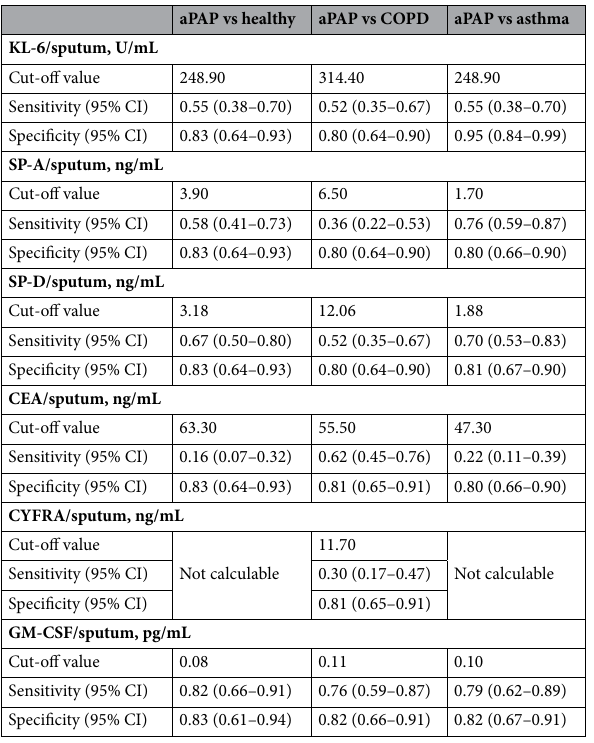
Table 4. Diagnostic and predictive power for aPAP-induced sputum sample biomarkers (specificity ≥ 80%) [per-protocol biomarker analysis]. aPAP autoimmune pulmonary alveolar proteinosis, CEA carcinoembryonic antigen, CI confidence interval, COPD chronic obstructive pulmonary disease, CYFRA cytokeratin-fragment, GM-CSF granulocyte–macrophage colony-stimulating factor, KL-6 Krebs von den Lungen 6, SP-A surfactant protein-A, SP-D surfactant